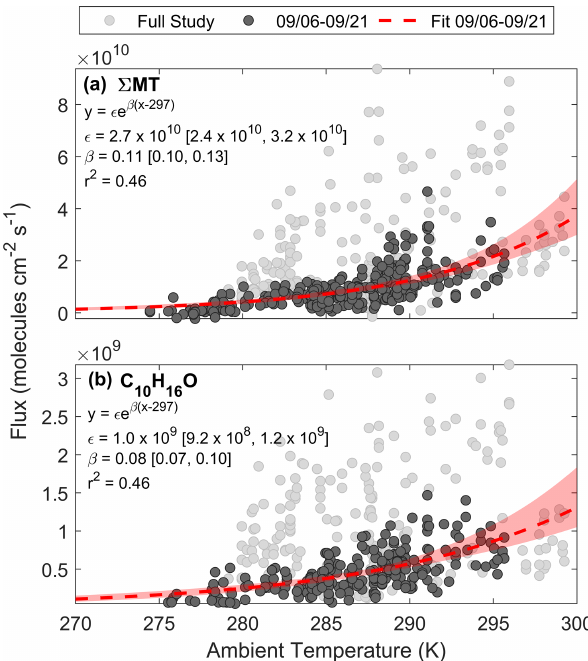
against am- 10 H 16 O